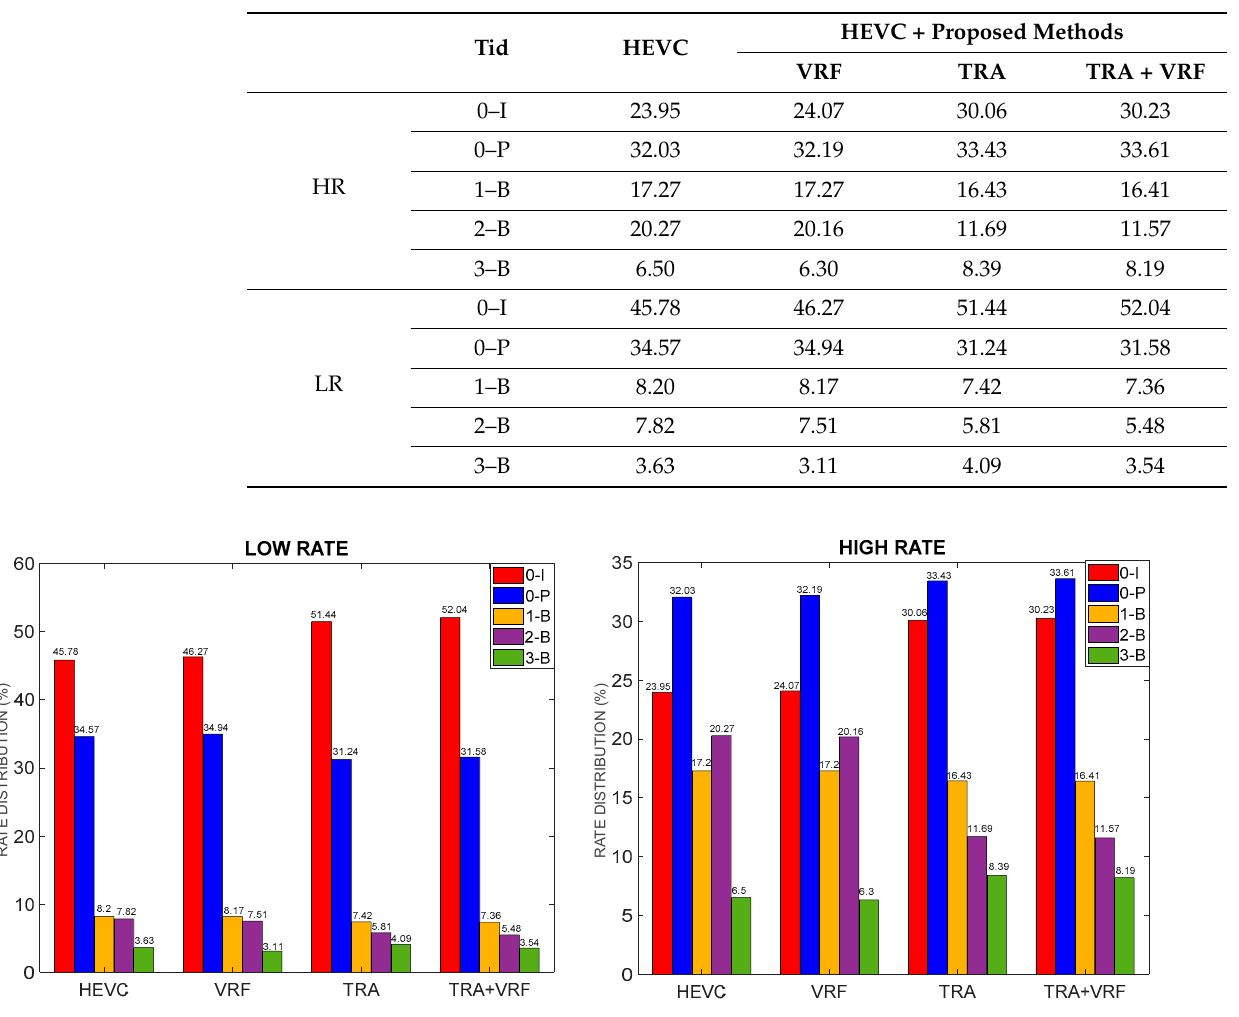
Table 6. Rate distribution (%) between temporal index.